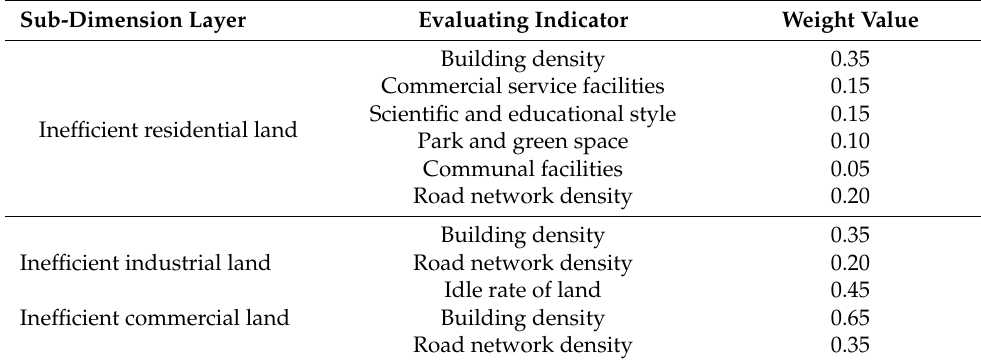
Table 5. Sub-dimension evaluation indicators and their